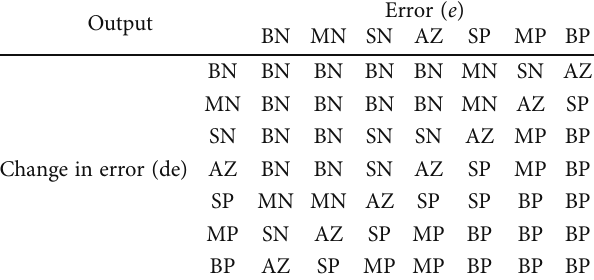
Table 1: Fuzzy rule base with seven membership functions.